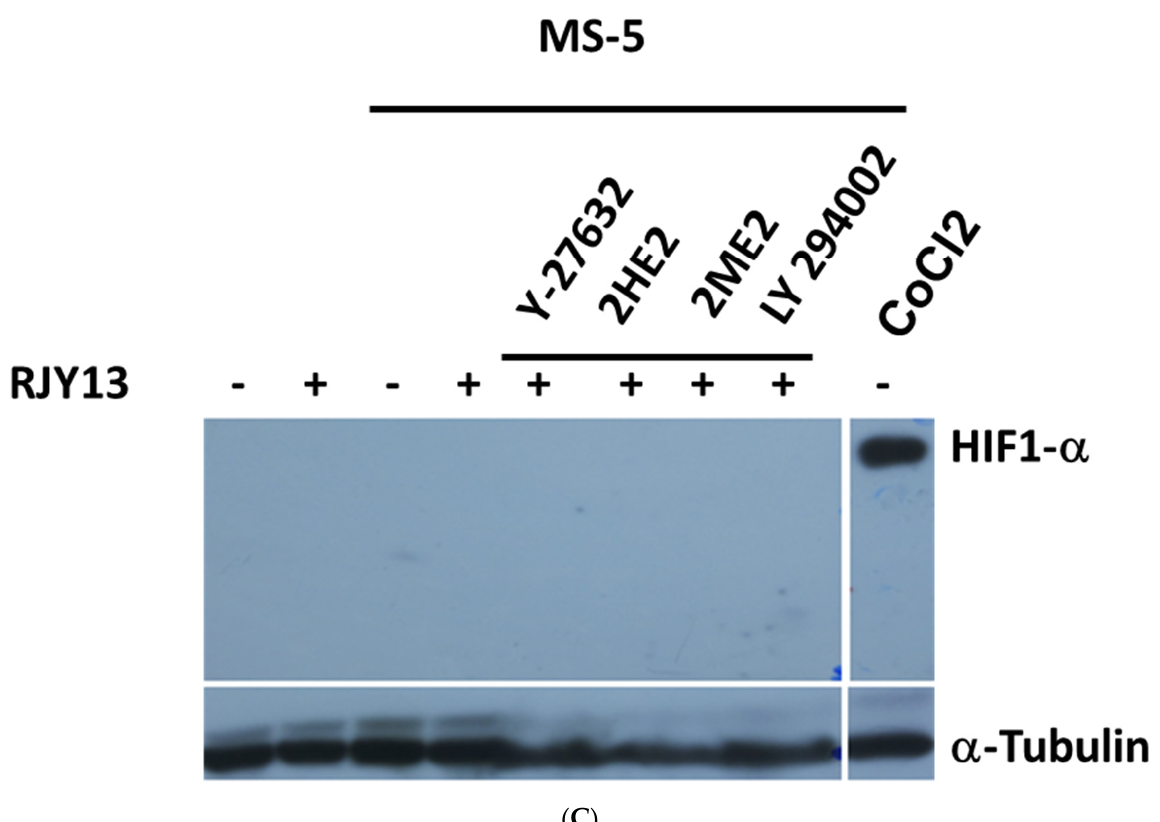
Figure 1. 2-methoxyestradiol restores platinum drug sensitivity to A2780CisR co-cultured with MS-5. ( A ) A2780CisR cells co-cultured with MS-5 and treated with RJY13 (5 μ M) and combined with 10 μ M of pharmaceutical inhibitors for 24 h. Cell lysates were used to monitor levels of cleaved PARP using PARP ELISA kit [15]. Pharmaceutical inhibitors including imatinib, inhibitor of Abl kinase [34], ceritinib, inhibitor of Alk kinase [35], Bay-61-3606 inhibitor of Syk kinase [36], tyrphostin AG-1296 inhibitor of PDGFR kinase [37], PD98059 inhibitor of MEK kinase [38], SB202190 inhibitor of p38 MAPK [39], gefitinib inhibitor of EGFR kinase [40], Y-27632 ATP-competitive inhibitor of ROCK-I and ROCK-II kinases [41], GNF-5 allosteric inhibitor of Abl kinase [42], ZM39923 inhibitor of JAK1/3 kinase [43], LY 294002 broad-spectrum inhibitor of PI3K kinase [44], ibrutinib inhibitor of Btk kinase [45], 2-methoxyestradiol endogenous metabolite of 17 β -estradiol [46], and axitinib inhibitor of VEGFR kinases [47]. The chemical structure of RJY13 is also shown. ( B ) A2780CisR cells were treated with RJY13 (5 μ M) in monoculture or in co-culture with MS-5 in the presence of 10 μ M of Y-27632, 2-hydroyestadiol, a prodrug of 2ME2, 2ME2, LY 294002, and BAY 87-2243 selective hypoxia-inducible factor-1 (HIF-1) inhibitor [30]. The chemical structure of 2ME2 is also shown. Levels of cleaved PARP were monitored by immunoblotting. ( C ) A2780CisR cells were treated with RJY13 (5 μ M) in monoculture or in co-culture with MS-5 in the presence of 10 μ M of Y-27632, 2-hydroyestadiol, 2ME2, LY 294002. In addition, A2780CisR cells were treated with 50 mM of CoCl 2 . α -Tubulin was used as a loading control. * p < 0.01 and ** p < 0.001. The experiment was repeated twice with comparable outcomes.